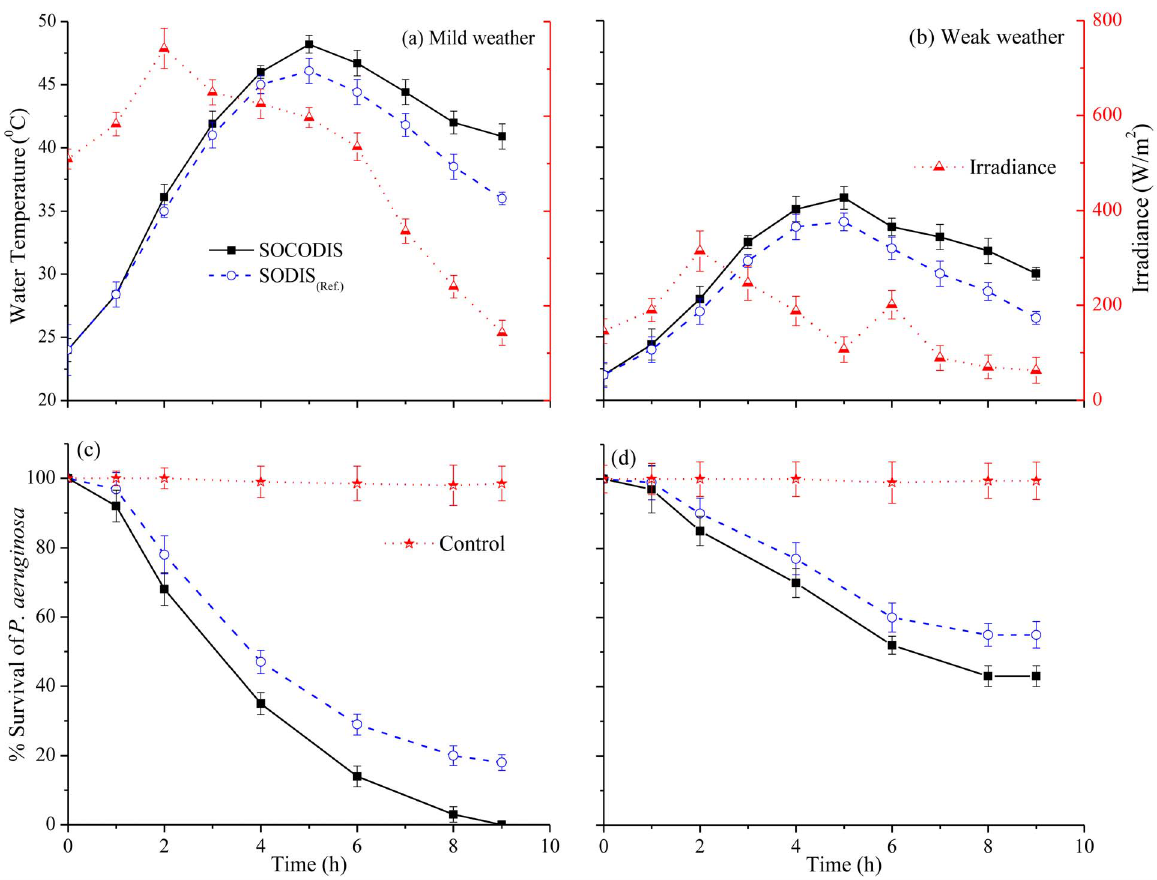
Figure 5. Comparison of temperature and P.aeruginosa inactivation in SODIS (Ref.) and SOCODIS system under mild (a & c), and weak (b & d) weather conditions.